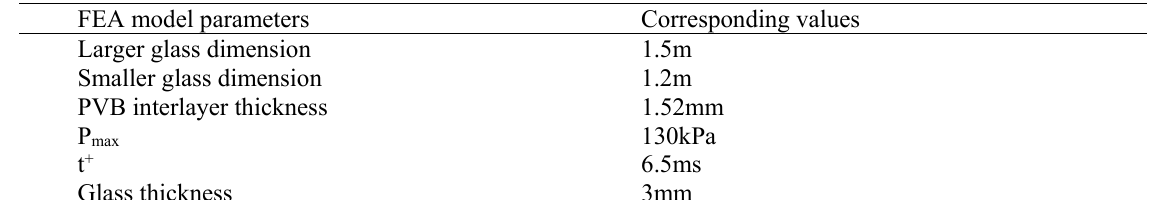
Table 1: parameters used for FEA modeling